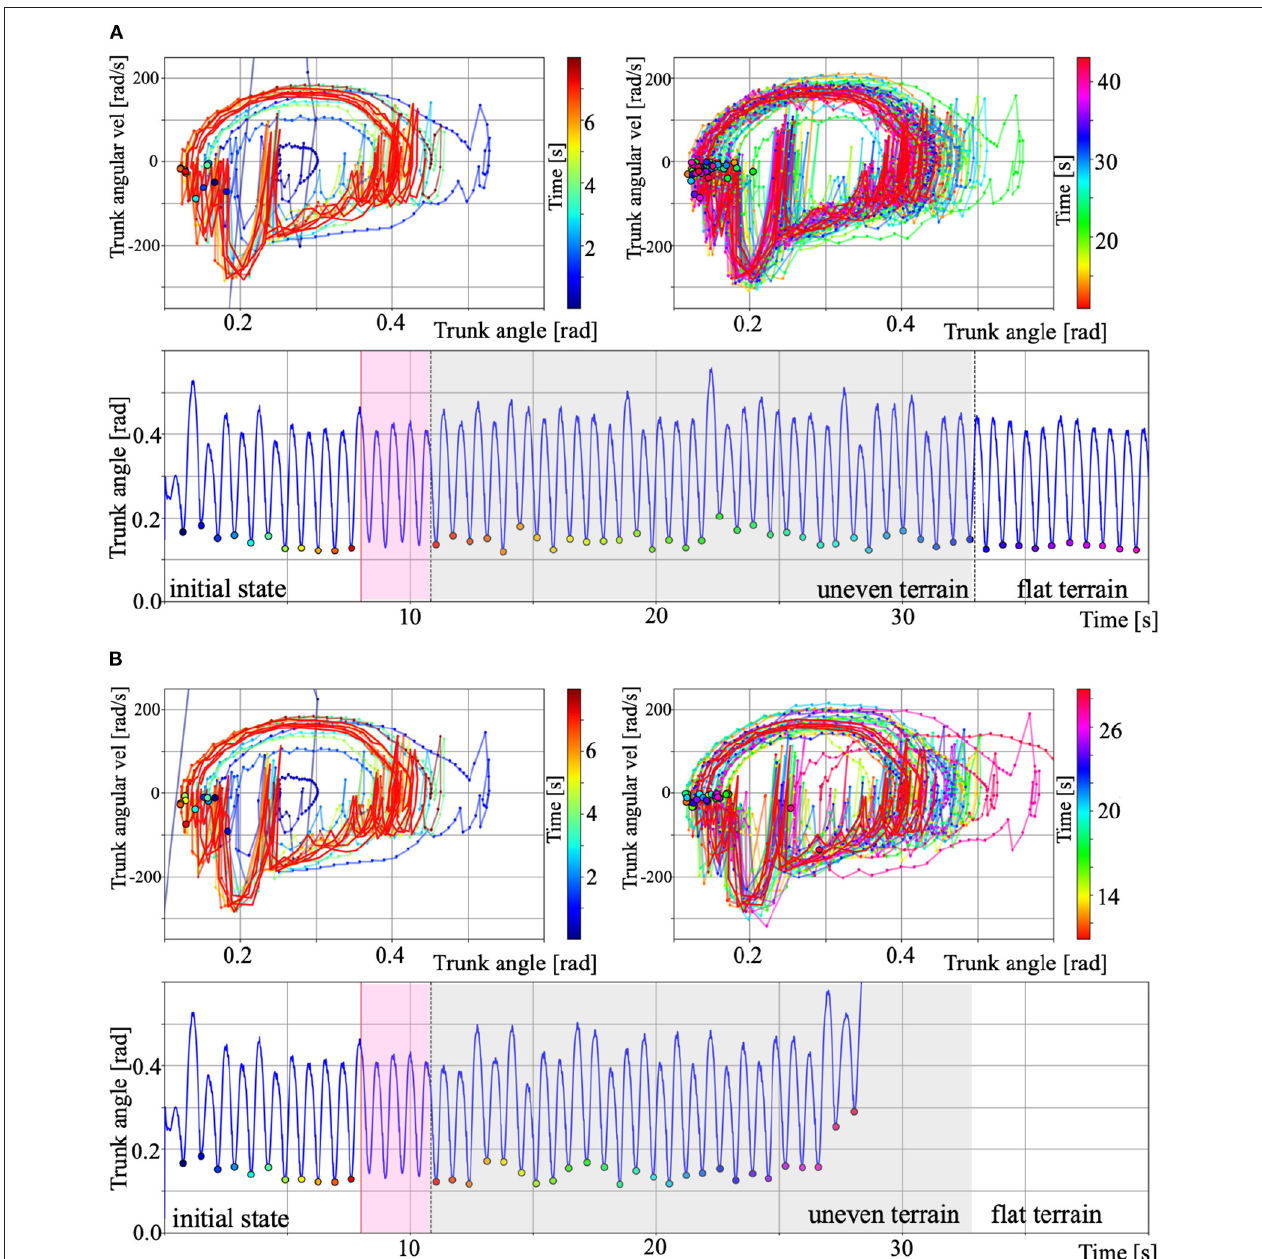
FIGURE 11 | Phase diagram of the trunk angle θ trunk and angular velocity ˙ θ trunk for the results of section 3.2. (A) Gait over uneven terrain. (B) Gait that could not move over uneven terrain. For A and B, the upper left and right panels show the period from initial to steady state and during uneven terrain walking. The colour legend for each panel indicate the time [s]. The red trajectories show the limit cycles from 8 s to the beginning of uneven terrain (pink area in the lower panels), which is defined as the steady-state trajectories. The black border points in the phase diagrams indicate the minimum trunk angle ( ˙ θ trunk = 0) during each walking cycle. We defined this point as the Poincaré section 6 (Nassour et al., 2014). We can then confirm the convergence of the walking to the steady state from the transition process. The lower graphs show the time evolution of the trunk angle θ trunk . The pink and grey area show the steady-state and period during uneven terrain walking, and the other areas show period during walking on flat